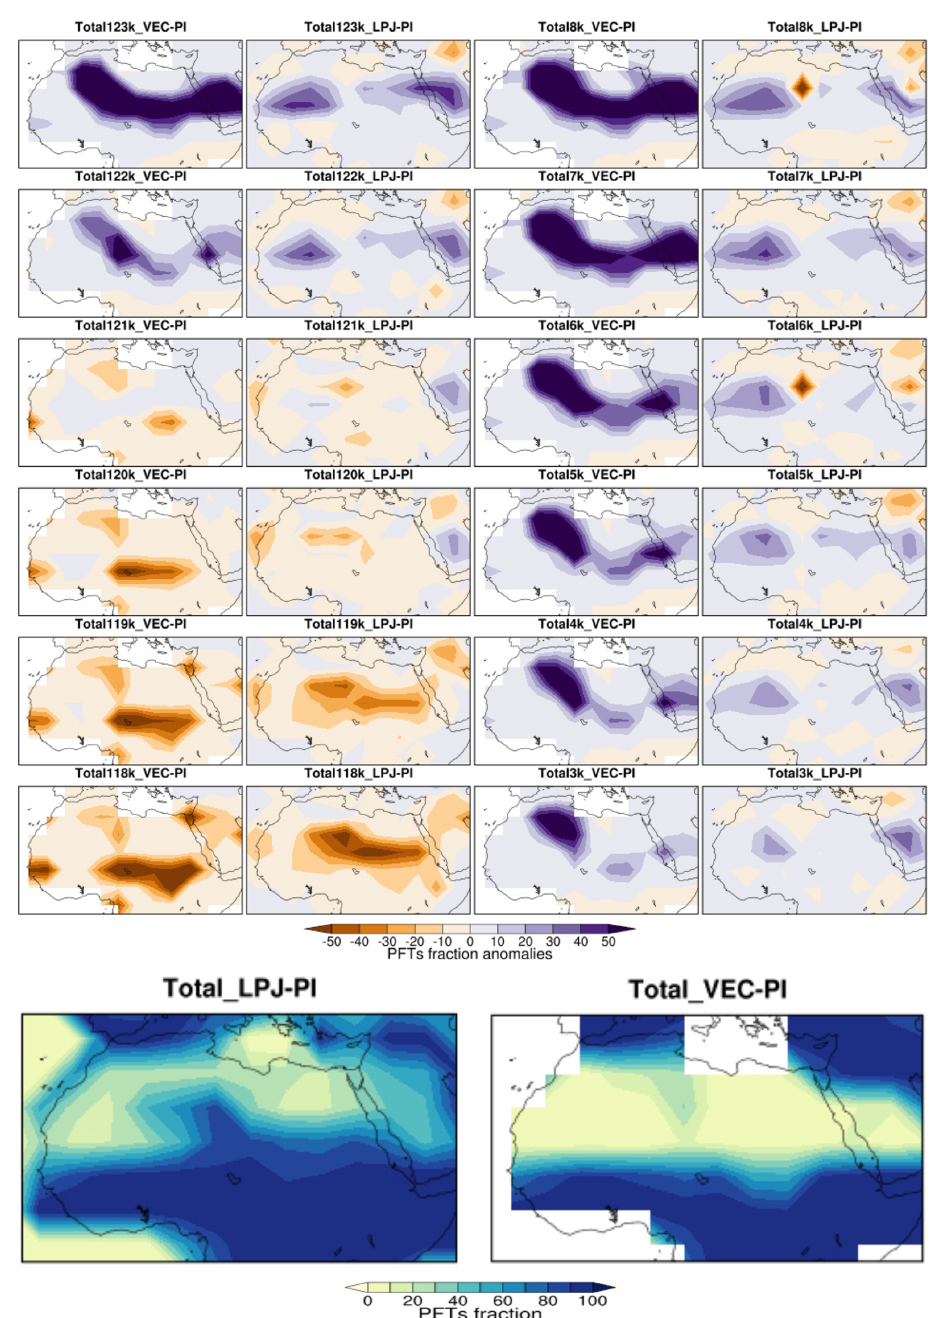
Figure 3. Total vegetation cover anomalies during the LIG (left two columns) and Holocene (right two columns) in the top panel compared to simulated pre-industrial vegetation (PI, bottom panels) from VECODE (left) and LPJ-GUESS (right).